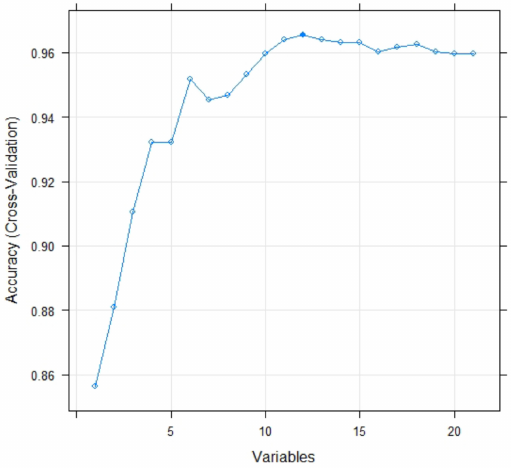
Figure 3. Screening diagram of dominant factors by using